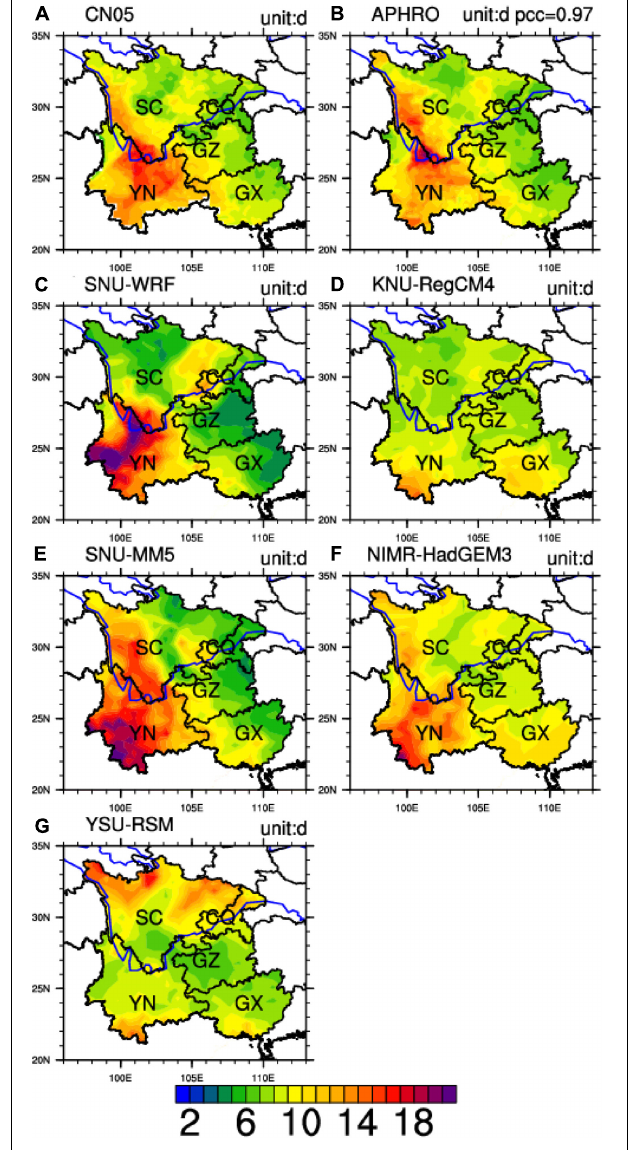
FIGURE 6 | Spatial distributions of mean annual maximum dry spell length (AMDSL) (unit: day) from two observations: (A) CN05, (B) APHRO; and five RCM simulations: (C) SNU-WRF, (D) KNU-RegCM4, (E) SNU-MM5, (F) NIMR-HadGEM3, and (G) YSM-RSM.